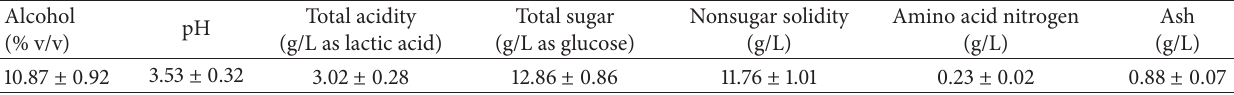
Table 1: General composition of the foxtail millet sake ( 𝑛 = 3